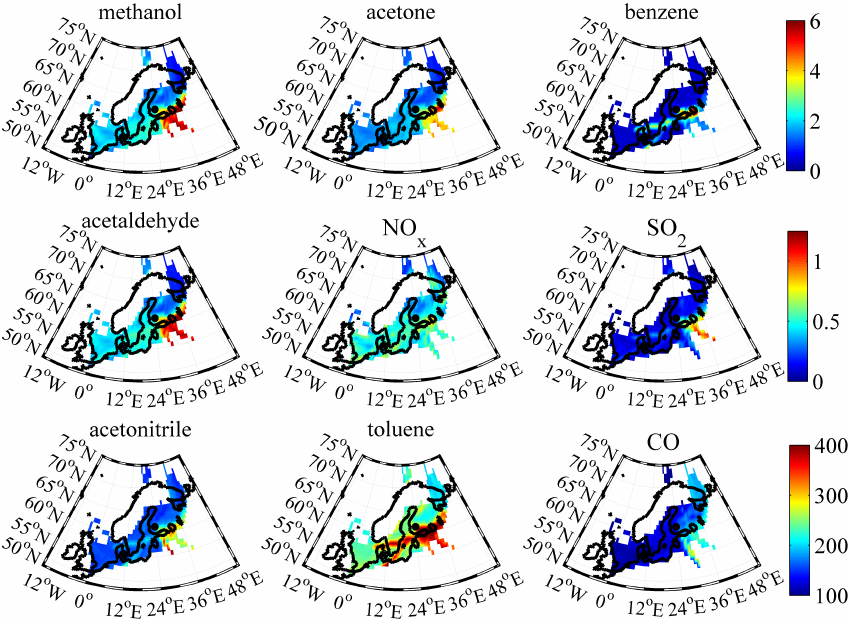
Figure 4. Mean trajectory fields for selected VOCs and trace gases (ppb v ) during the forest fires in summer 2010. VMR scales are presented on the right, with the scale for each compound being further multiplied in the case of each compound by the indicated factor 10, 100 or 1000 if needed. Topmost row: methanol, acetone, and benzene (benzene multiplied by 10). Middle row: acetaldehyde, NO x , and SO 2 . Bottom row: acetonitrile (acetonitrile multiplied by 1000), toluene (toluene multiplied by 1000), and CO. The SMEAR II site is marked by a dot in the